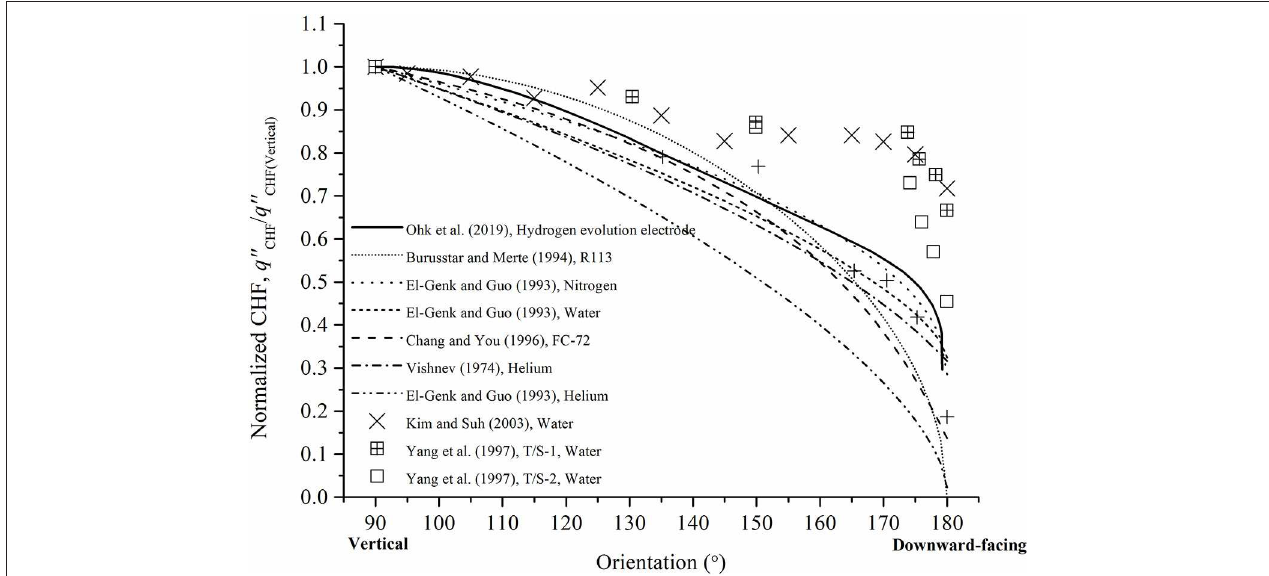
FIGURE 2 | Comparison of normalized CHF of existing studies with hydrogen evolution system (Ohk et al.,